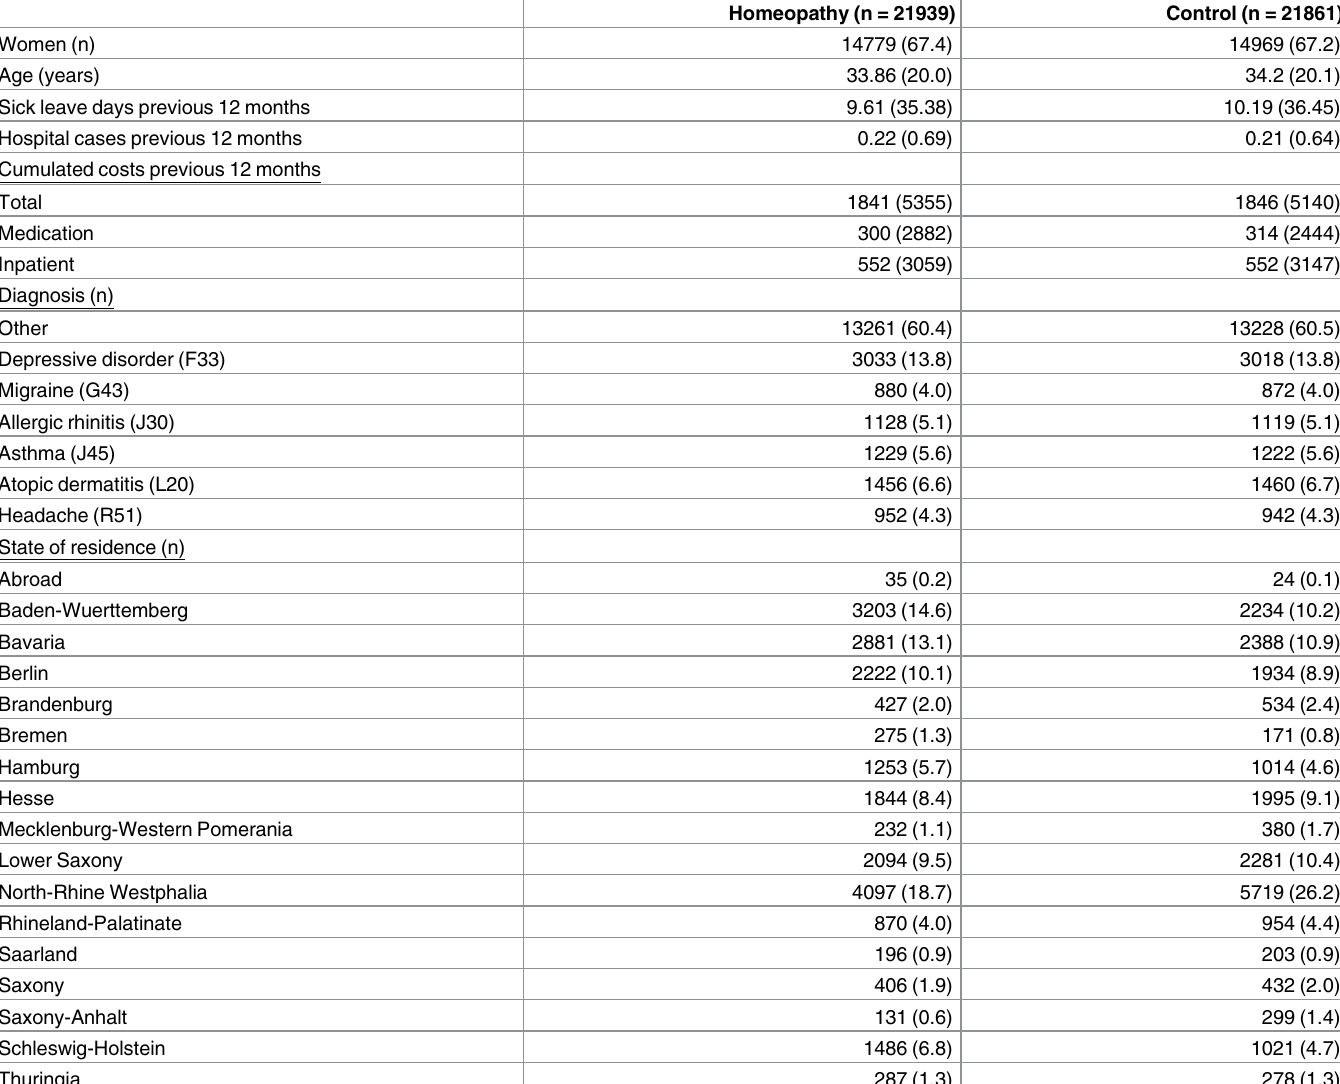
Table 1. Baseline characteristics of all patients. Data includethe mean (SD) and the number of